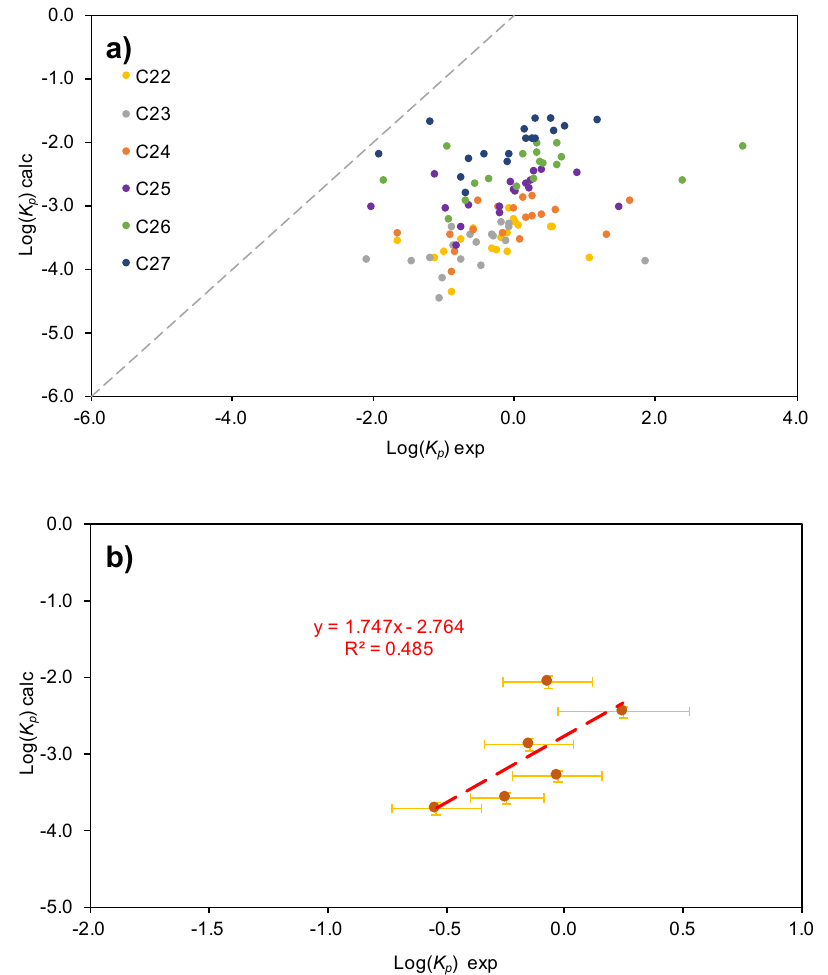
Figure 15. Experimental and predicted Kp for semi-volatile ALKs for each collected sample ( a ), and averaged for each ALK species ( b ).